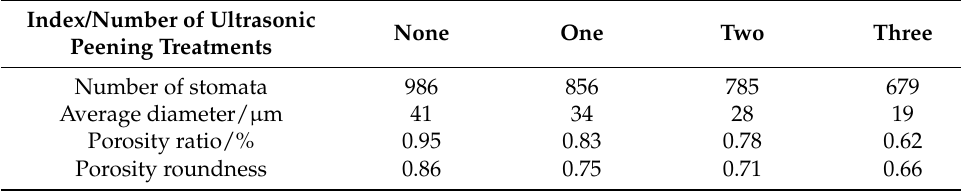
Table 4. Pores of samples with the different interlayered ultrasonic peening times [81].